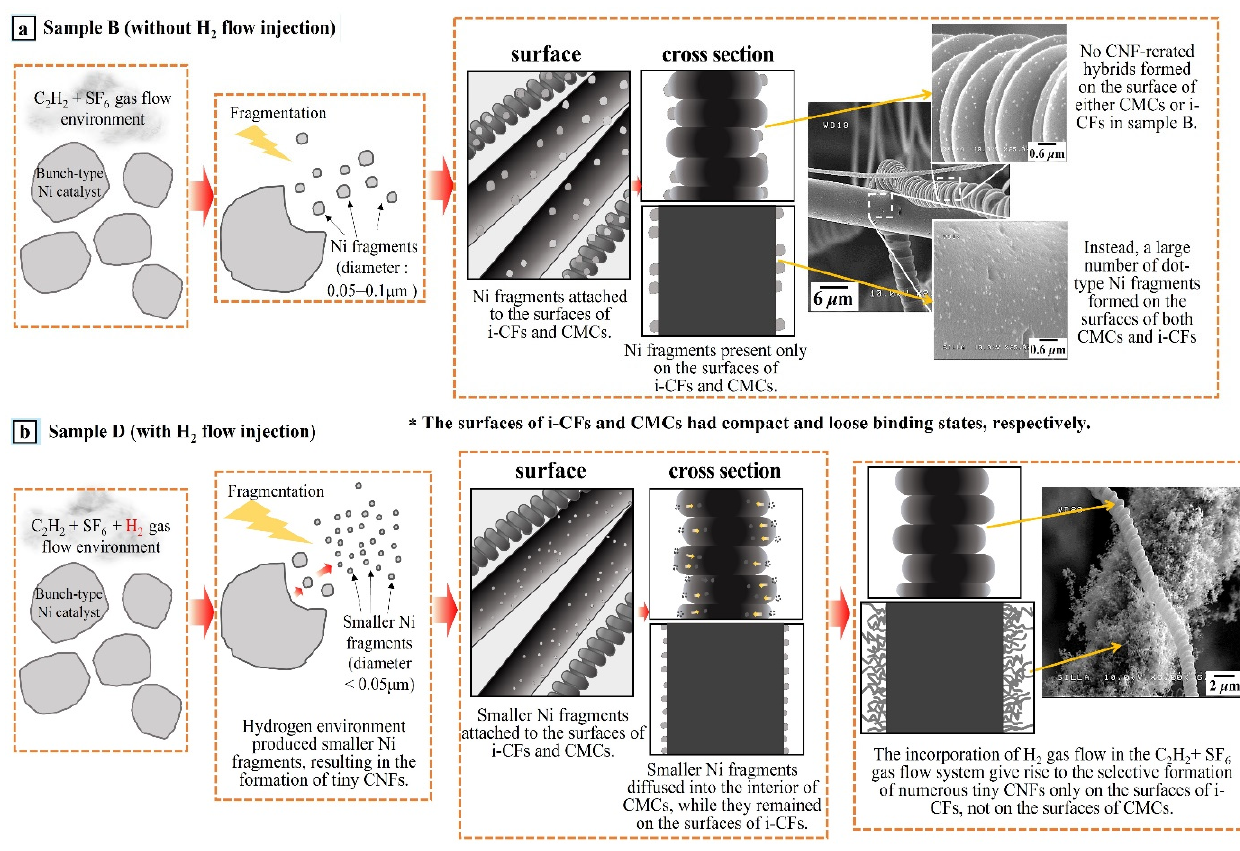
Figure 8. Systematic diagrams indicating ( a ) the existence of a large number of dot-shaped Ni fragments on the surfaces of both CMCs and i-CFs in the C 2 H 2 + SF 6 gas flow system and ( b ) the selective formation of numerous tiny CNFs only on the surfaces of i-CFs and not on the surfaces of CMCs due to the incorporation of H 2 gas flow into the C 2 H 2 + SF 6 gas flow system.